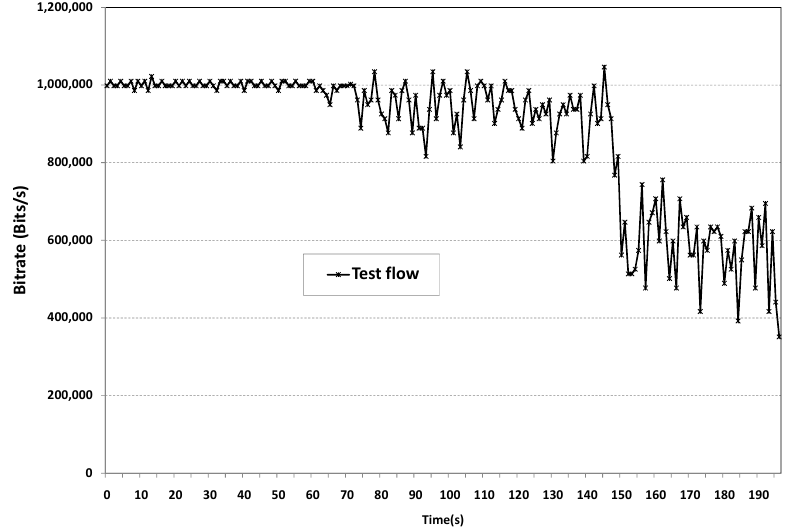
Figure 6. Effect of increasing background traffic load on test flow without adaptive CNQF reconfiguration